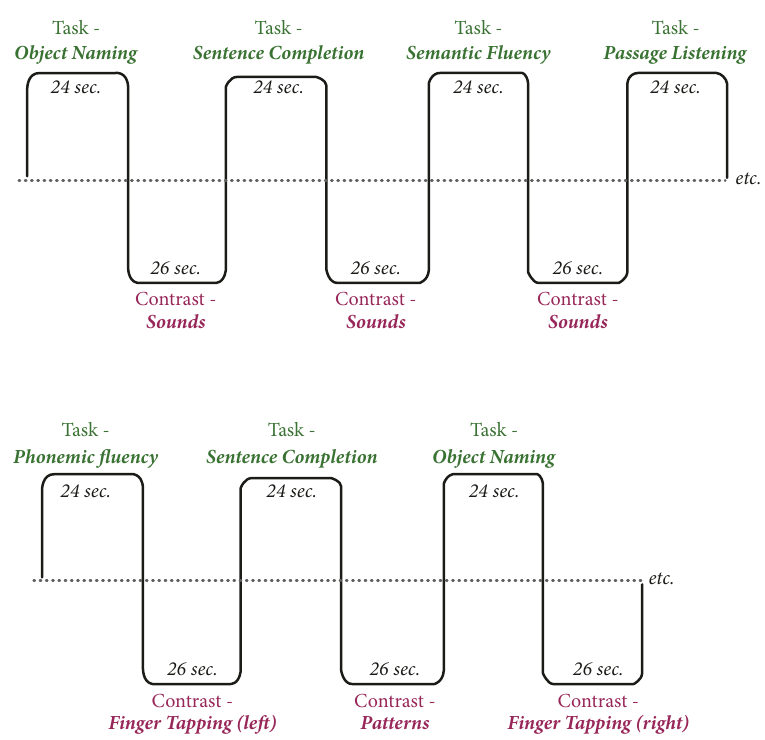
Figure 1: Diagrams of the auditory language paradigm (top) and of the visual language paradigm